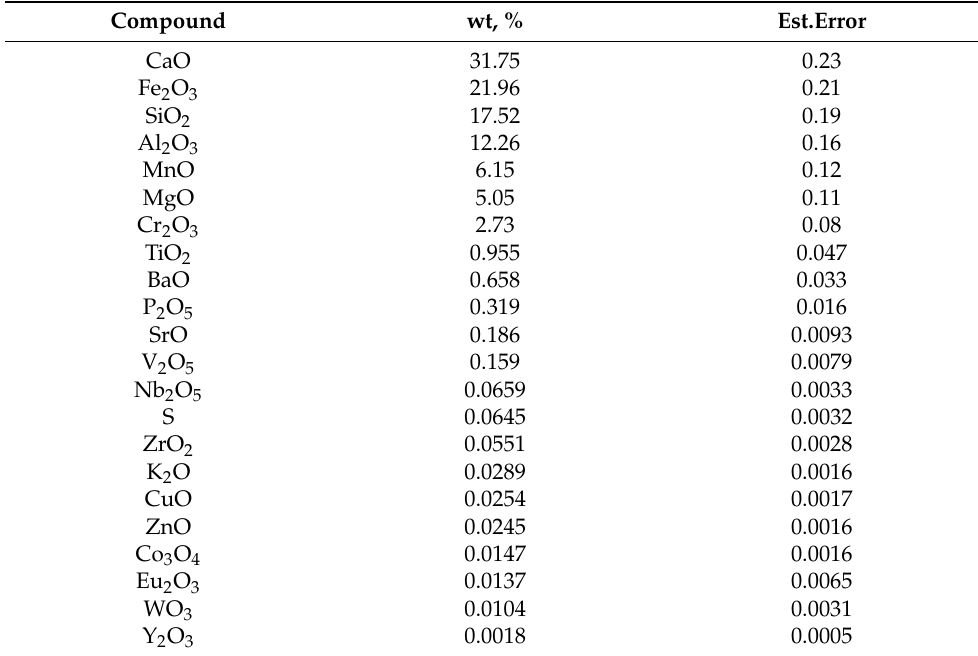
Table 2. X-ray fluorescence of electric arc furnace slag.